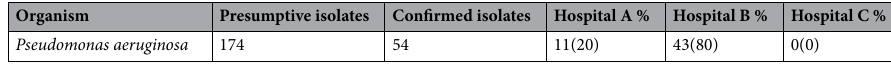
Table 1. Total number of P. aeruginosa isolates recovered from the three hospital effluents.